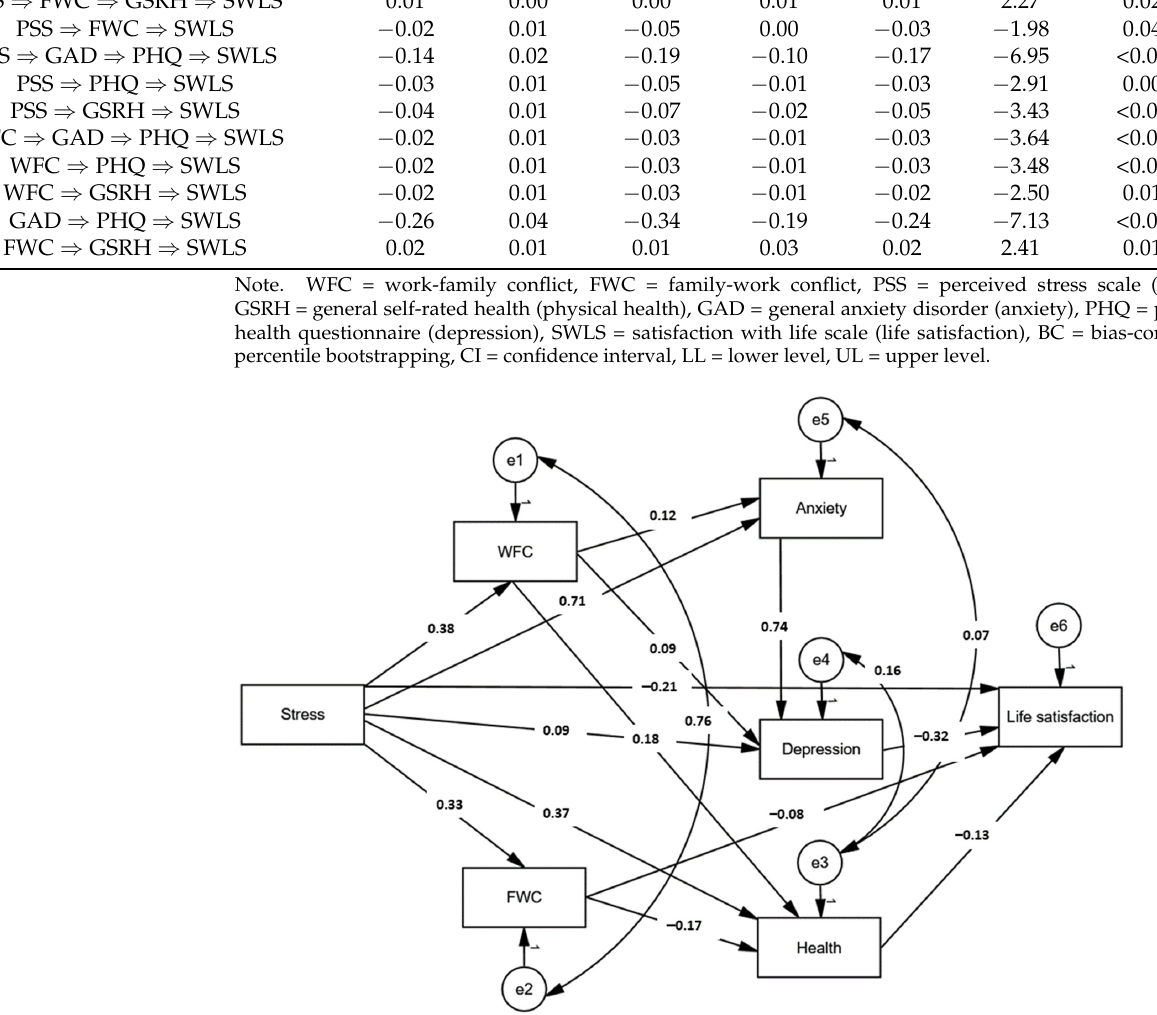
Figure 3. Path model for associations between work-family conflicts and well-being dimensions. All numbers represent statistically significant standardized regression weights ( β ). Table 4. The path model for life satisfaction ( N = 736).